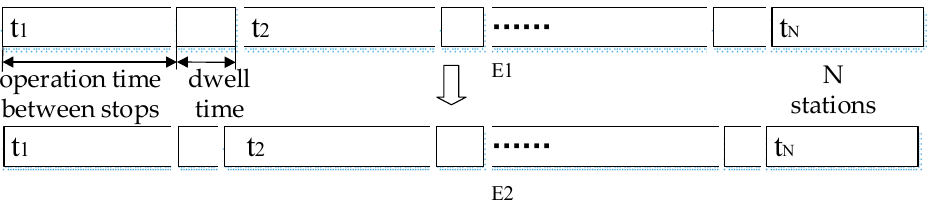
Figure 10. Schematic diagram of dwell time modification.